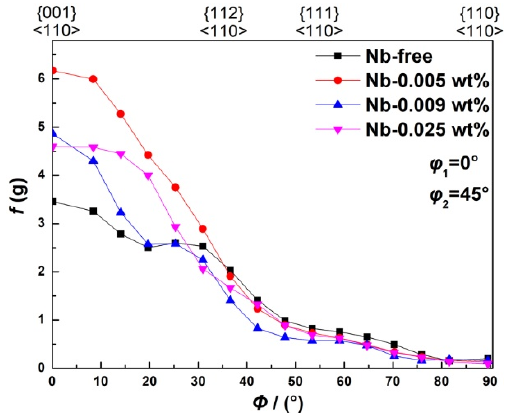
Figure 10. Orientation density distribution of α fiber.